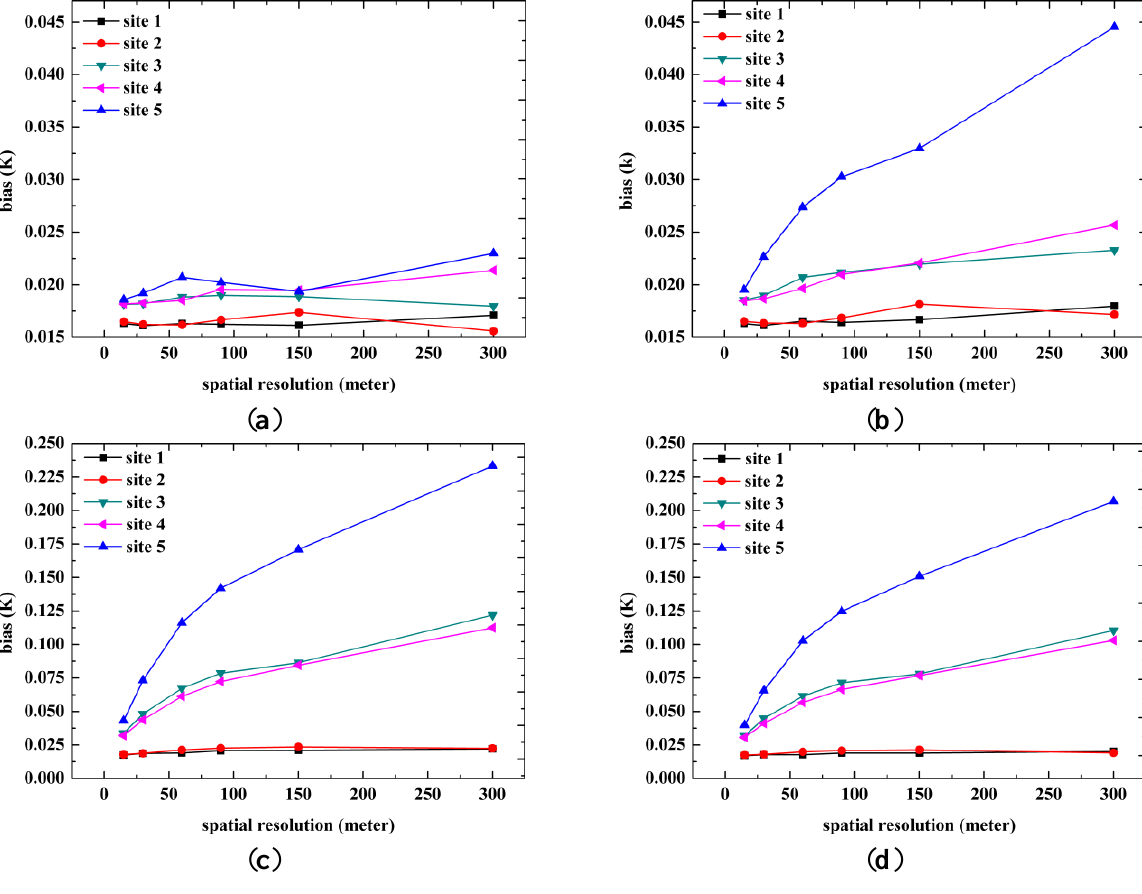
Figure 5. Comparison between the rectified TASI LST and the distributed LST by ( a ) Method 1; ( b ) Method 2; ( c ) Method 3 and ( d ) Method 4. The difference is described by the mean absolute bias in the LST image (Equation (8)).